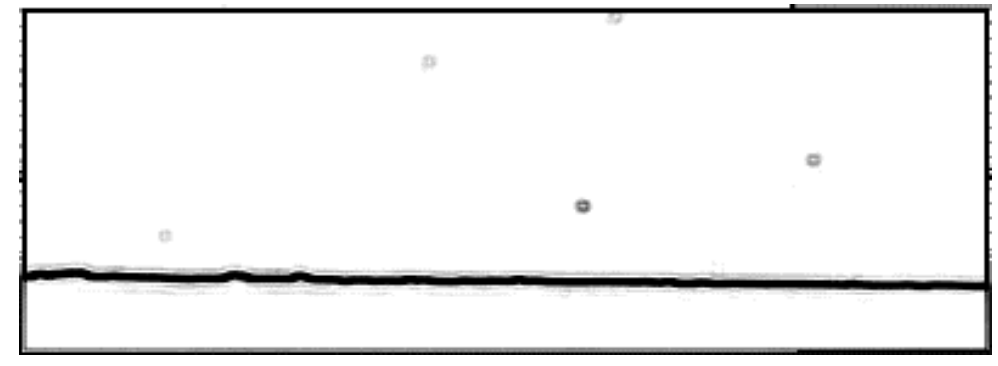
Figure A1. Representative filtered frame with visible particles.